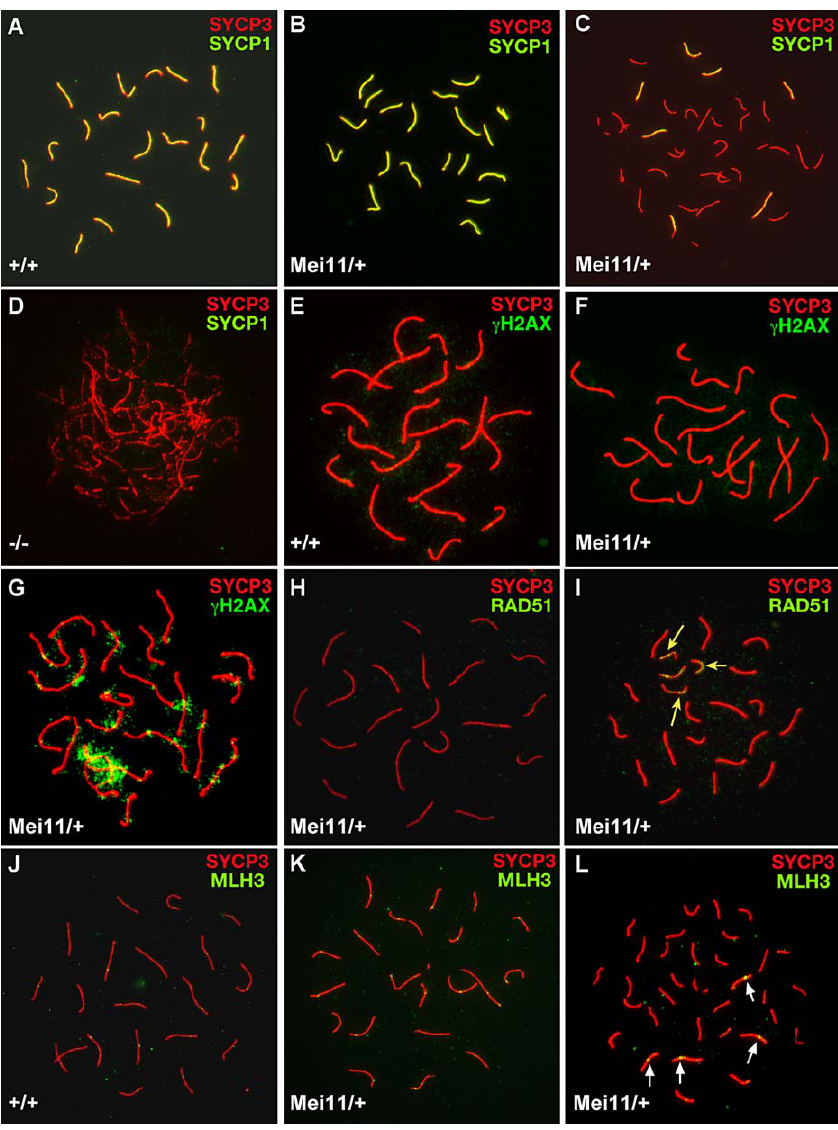
Microspread oocyte nuclei of embryonic ovaries (17.5 d postcoitus) were fluorescently immunolabeled with the indicated antibodies. All animals were in the B6 background. Dmc1 Mei11 is abbreviated as Mei11, and þ or (cid:3) in genotypes refers to the wt or null alleles of Dmc1, respectively. (A and B) Mid-pachytene nuclei with full synapsis and 20 bivalents. (C) Only a few autosomes are synapsed (yellow staining along chromosomal